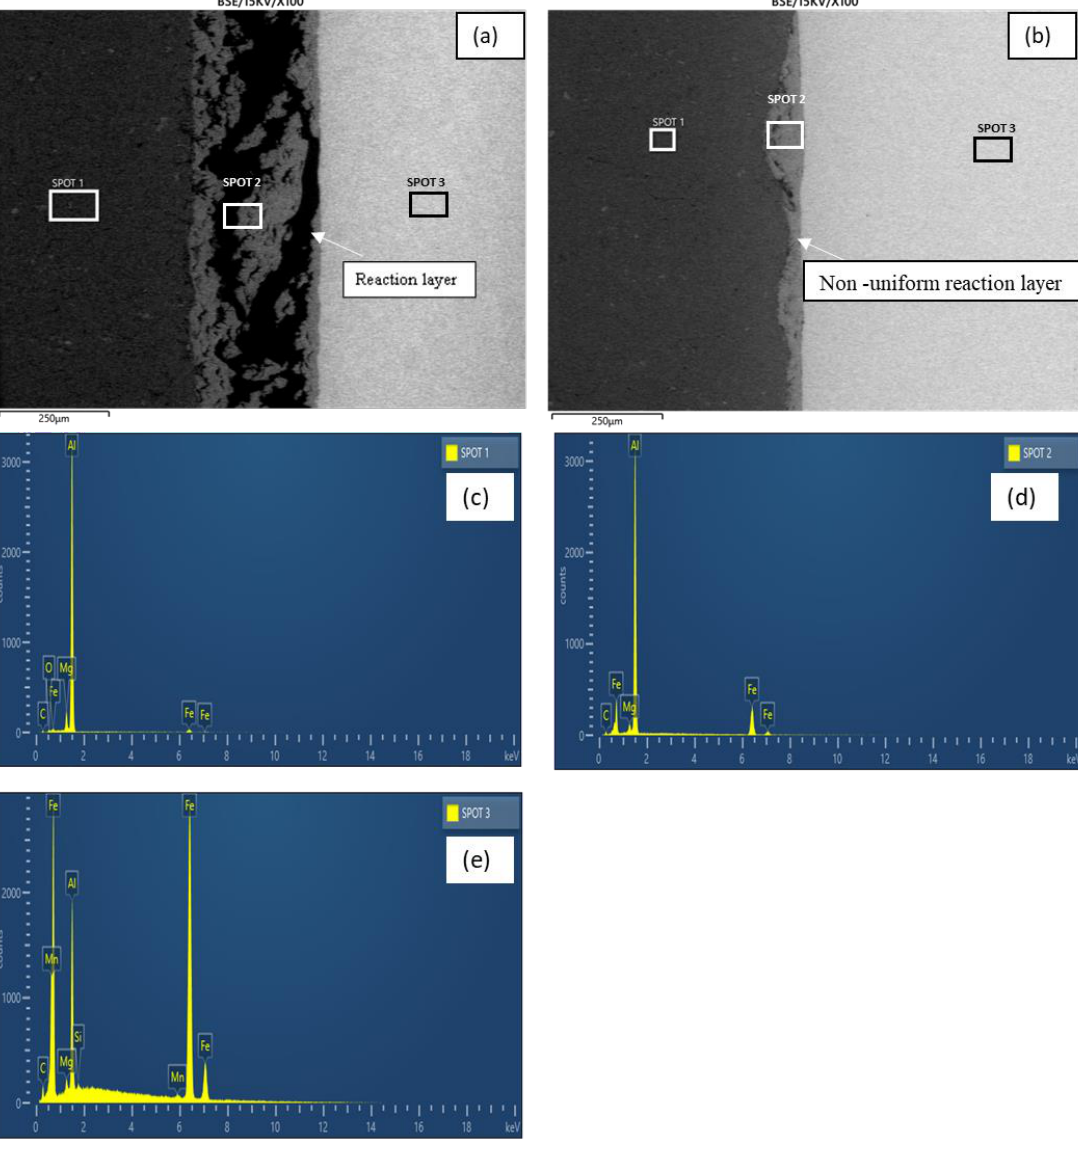
Figure 11. ( a ) Micrograph of sample E; ( b ) Micrograph of sample I; ( c ) Sample I EDX analysis (spot 1); ( d ) Sample I EDX analysis (spot 2); ( e ) Sample I EDX analysis (spot 3).